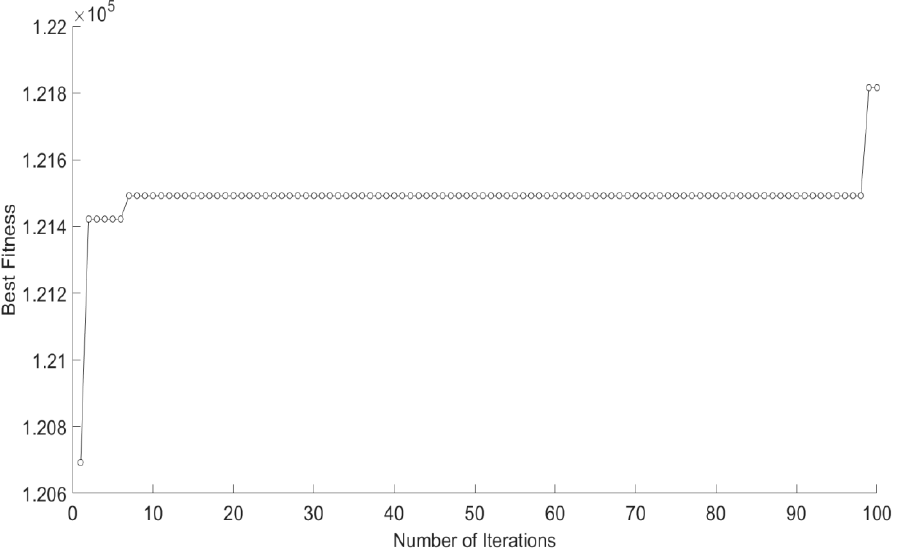
Figure 10. The best fitness trajectory of CRO-CPSO for 2577 intersections and 3497 sections of an urban road network.